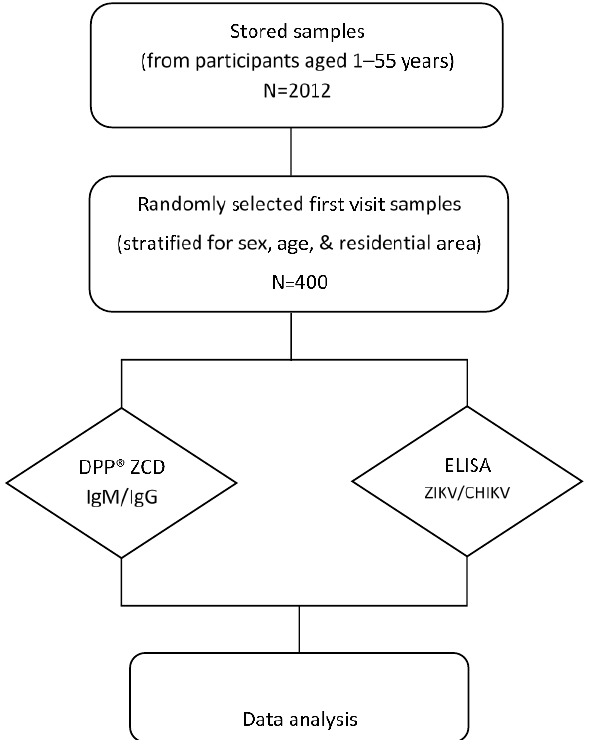
Figure 1. Schematic diagram of the study design and procedures. Four hundred serum samples were selected and used to perform ZIKV and CHIKV immunoglobulin (Ig) G enzyme-linked im- munosorbent assay (ELISA) tests (DENV ELISA results were used from previous study) and the DPP ® ZCD IgM/IgG